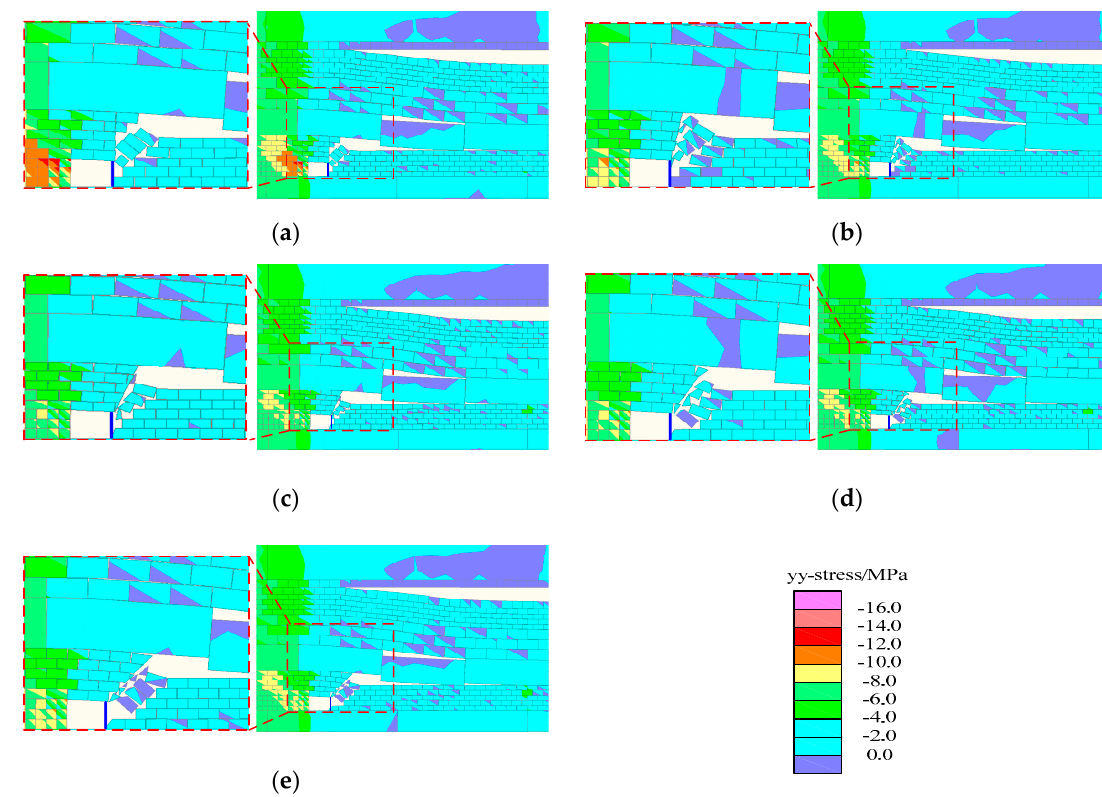
Figure 11. Numerical calculation results of vertical stress contours for different cutting angles. ( a ) Cutting angle 90 ◦ ; ( b ) Cutting angle 80 ◦ ; ( c ) Cutting angle 70 ◦ ; ( d ) Cutting angle 60 ◦ ; ( e ) Cutting angle 50 ◦